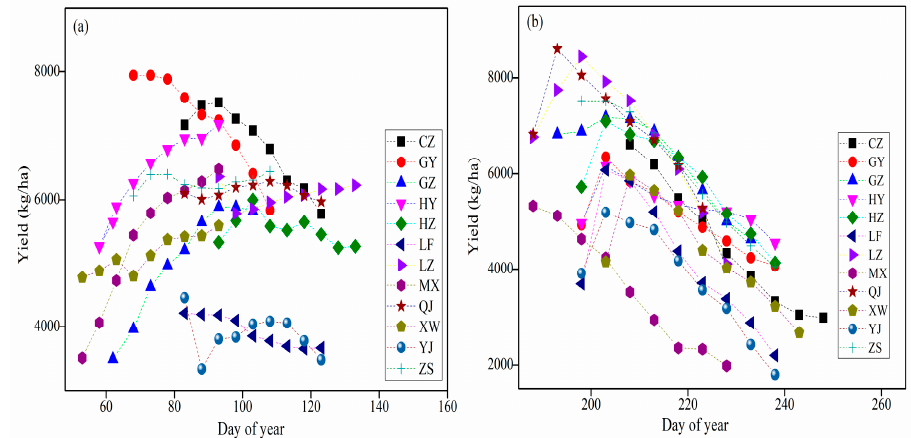
Figure 7. Simulated changes in planting dates and the corresponding yields at each site: ( a ) Early mature rice and ( b ) late mature rice.